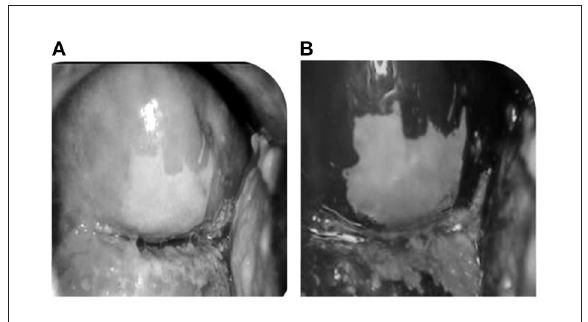
FIGURE3 (A) Before screening with acetic acid. (B) After the acetic screening.